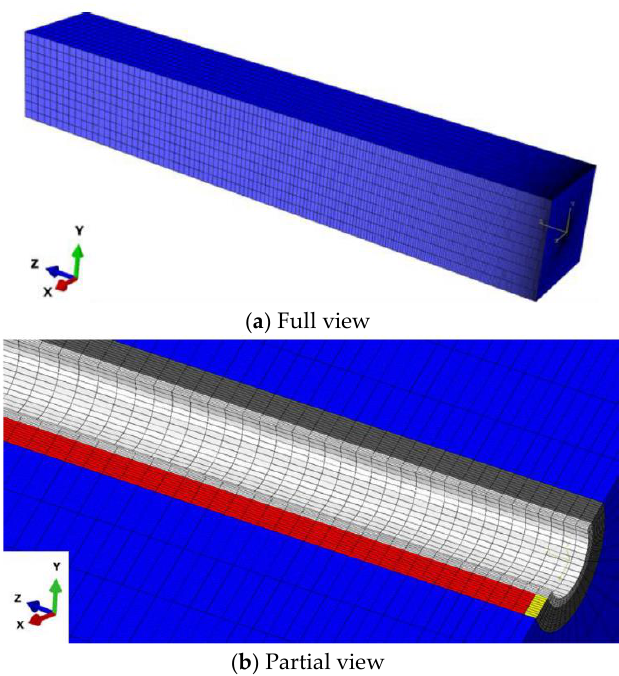
Table 3. The load data. Figure 4. Axial crack propagation model of cement sheath body. Figure 4. Axial crack propagation model of cement sheath body.